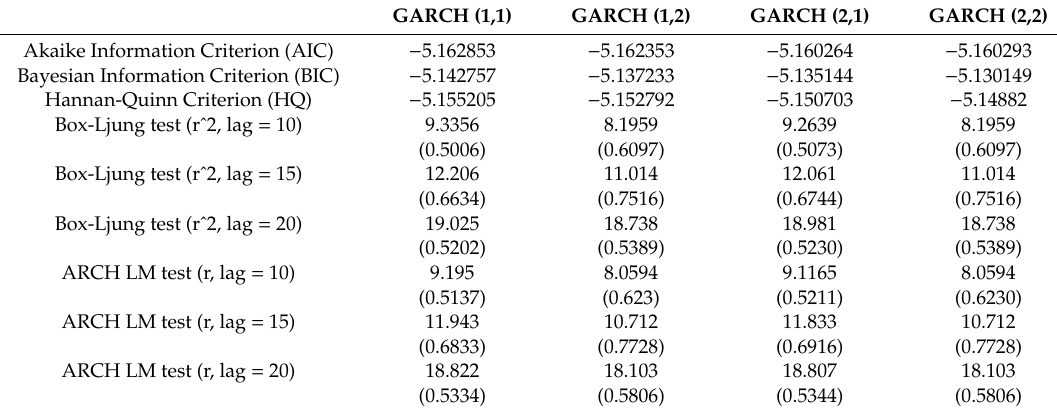
Table 3. Estimation results of GARCH models for ASSI.